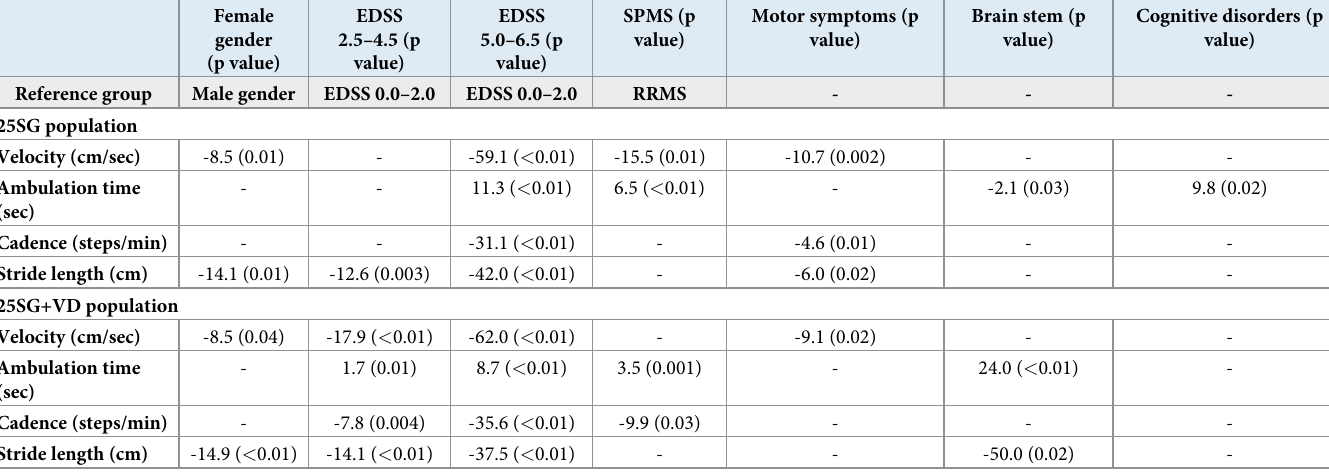
Table 4. Multivariate models for each gait parameters by GAITRite 1 device (25SG and